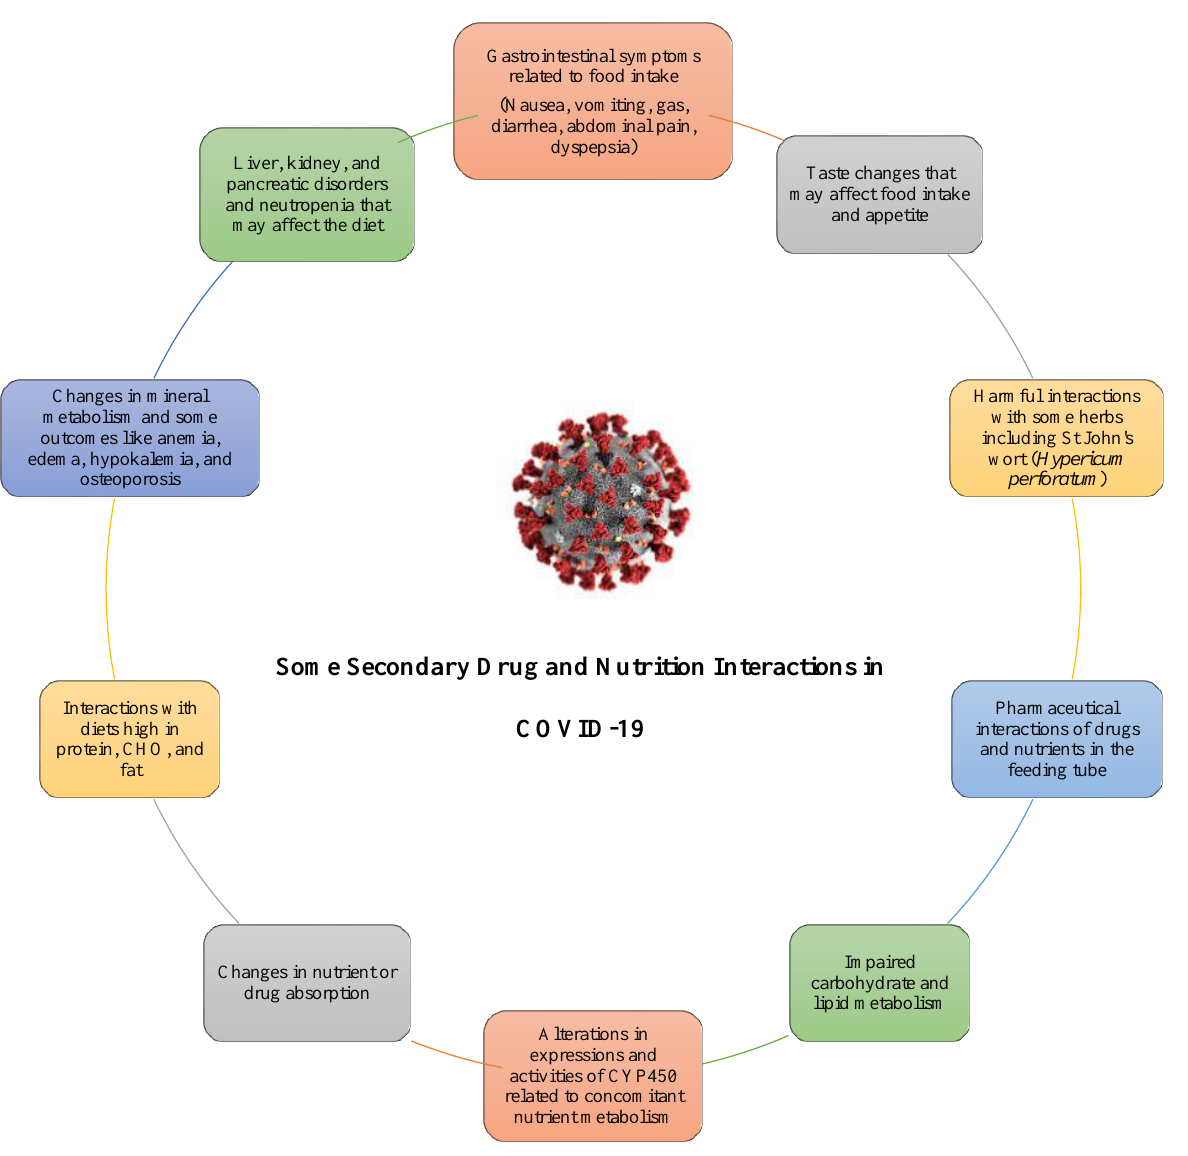
Figure 1. An overview of potential secondary nutritional interactions of drugs currently being used in treating COVID- 19.